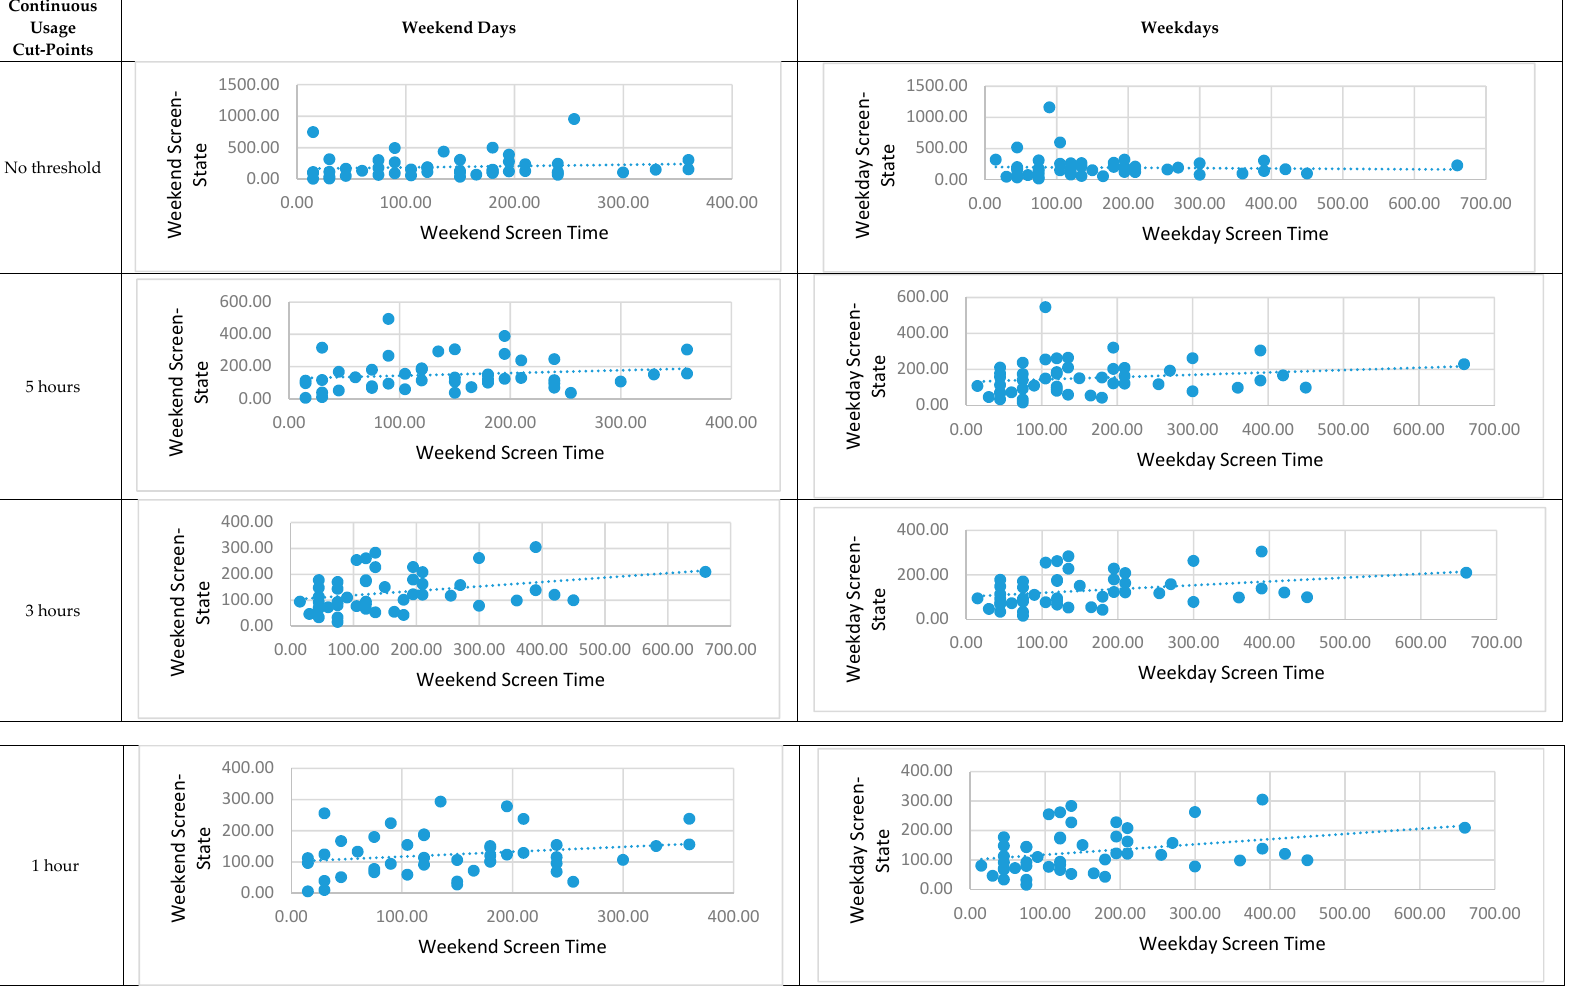
Figure 5. Correlation between objective screen-screen state with 20 second notification cut-point and subjective screen time across weekdays and weekend days.